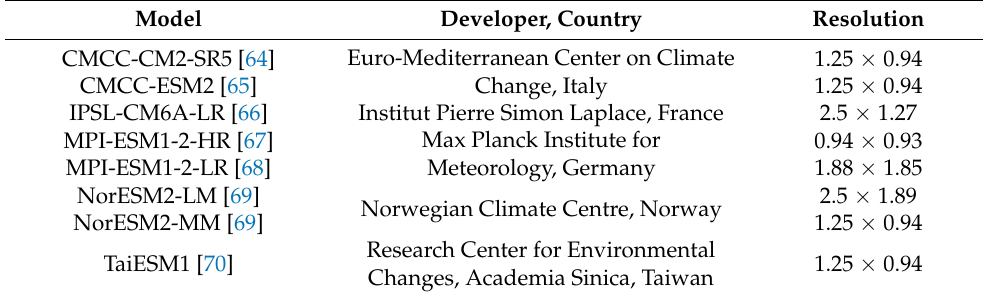
Table 1. CMIP6 models analyzed in this